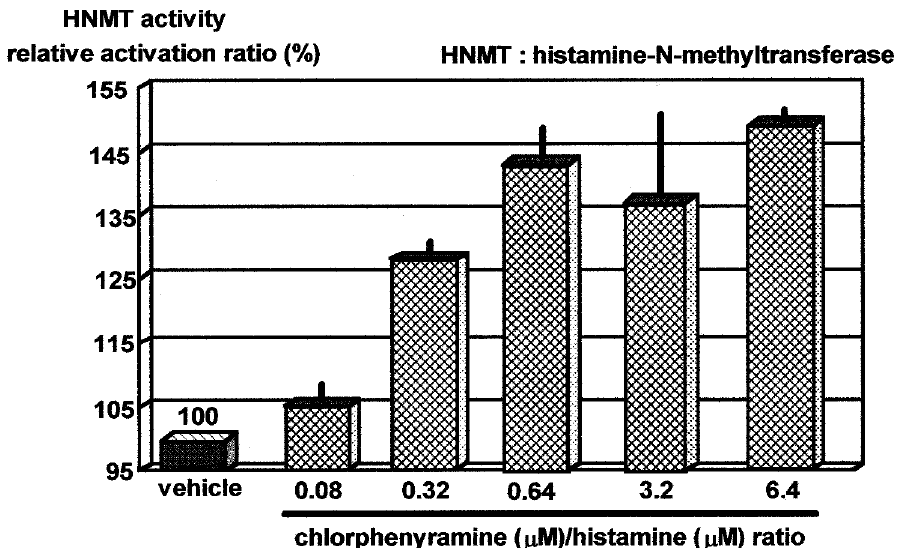
FIG. 2. Activation of histamine- N -methyltransferase activity in rat brain by chlorpheniramine maleate as an antihistamine. The vertical axis represents the relative activation ratio compared with value obtained without antihistamines; the horizontal axis represents the chlorpheniramine/histamine